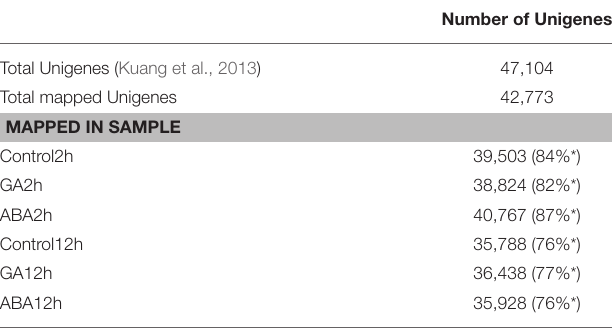
TABLE 1 | Summary of the mapping reads and Unigenes identified by RNA-seq.